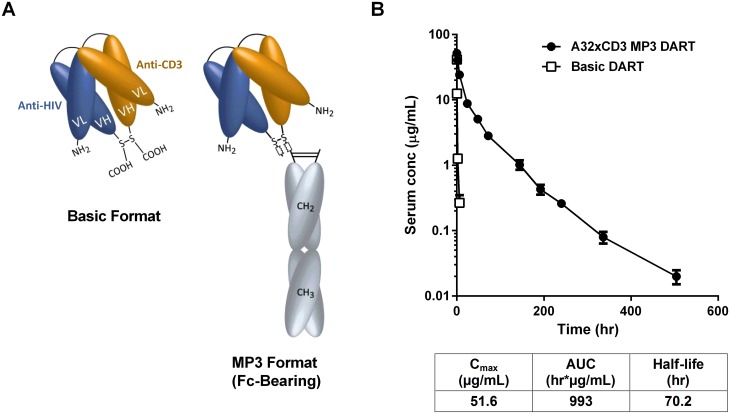
HIVxCD3 DARTs in basic and MP3 format.(A) Schematics of DARTs in basic and MP3 (Fc-bearing) format are shown. The anti-HIV and anti-CD3 domains are colored in blue and orange, respectively, and the human IgG1 Fc domains are shaded in grey. The chains of the Fc domain are modified to contain L234A/L235A mutations that inhibit Fc binding to activating FcγRs. The chains of the Fc domain do not inhibit binding to FcRn, which prolongs serum half-life and exposure. (B) Pharmacokinetic profile in human FcRn transgenic mice. The A32xCD3 MP3 DART was administered at 5 mg/kg by iv injection and serum concentrations were measured over time (closed circles). For comparison, the serum concentration-time curve for a basic DART with different specificities is shown (open squares). The PK parameters for the A32xCD3 MP3 DART are presented in the table.